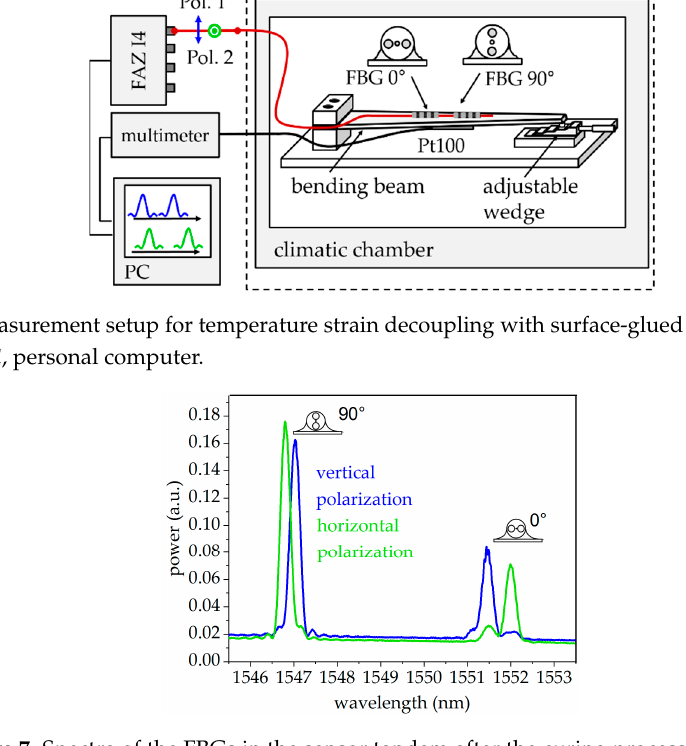
Figure 7. Spectra of the FBGs in the sensor tandem after the curing process at − 30 °C.